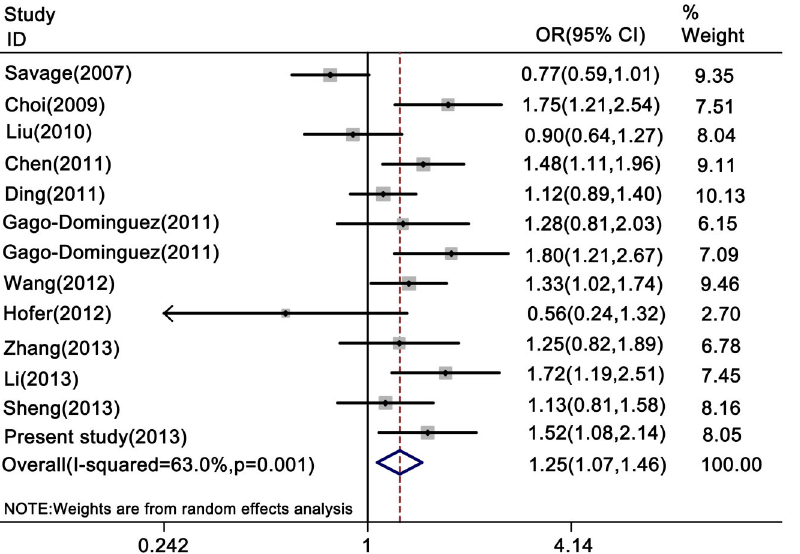
Figure 2. Forest plot of cancer risk associated with the rs2736098 polymorphism (AA vs. GG). The rs2736098 polymorphism was associated with an increased risk of cancer in the homozygote comparison (AA vs. GG).